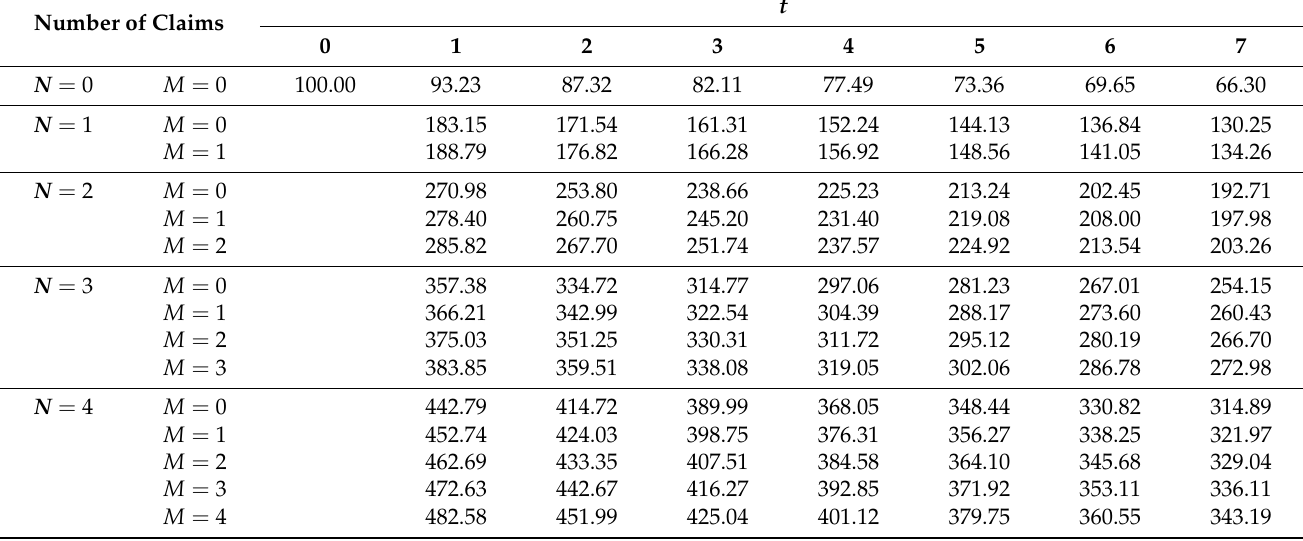
Table 4. Bonus-malus premiums based on the Poisson binomial-exponential beta distribution for the frequency component where N represents the total number of claims and M represents those that the claim size is larger than Φ =